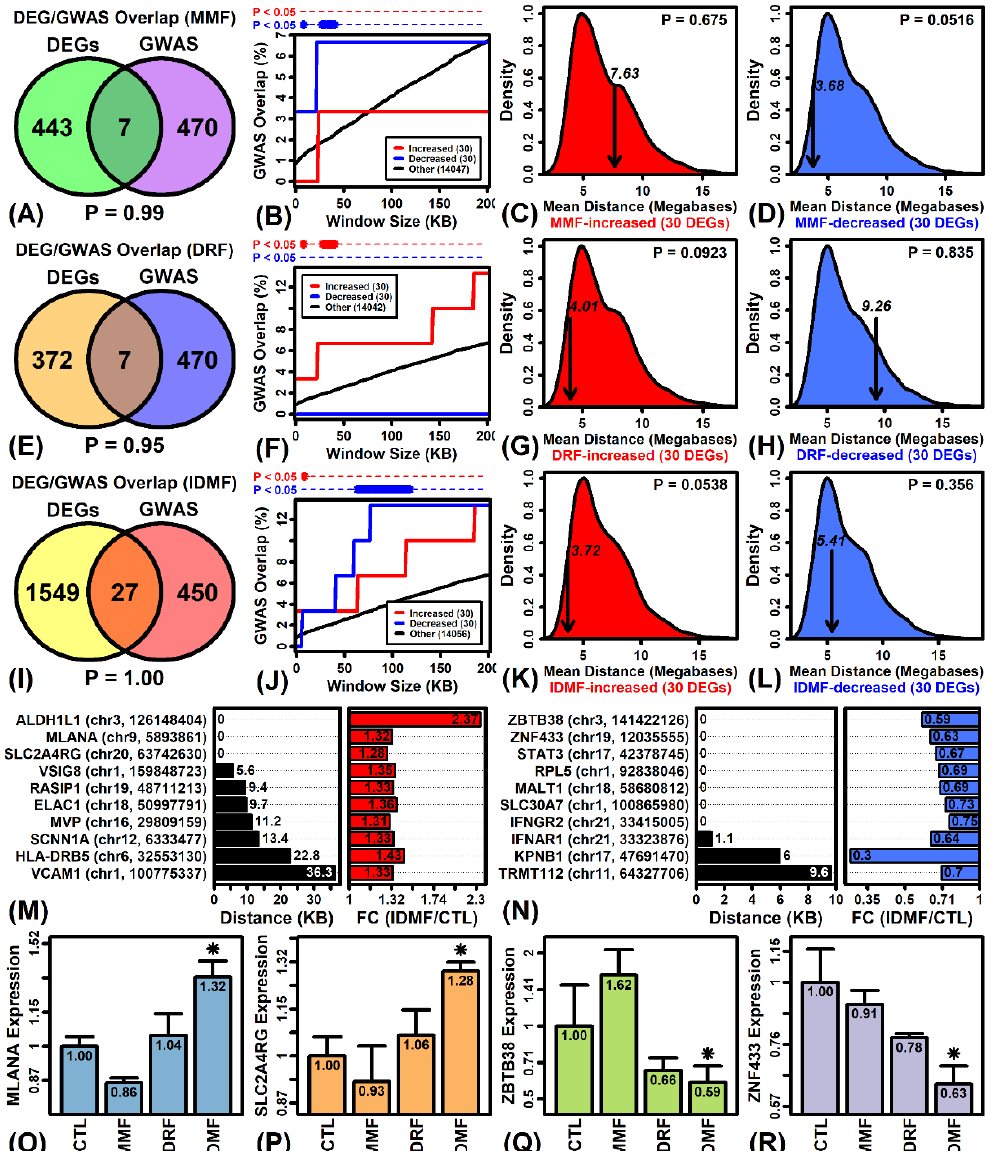
Figure 7. MS-associated genes from GWAS studies and their overlap with DEGs. ( A , E , I ) Overlap between DEGs and MS-associated genes from the NHGRI-EBI GWAS Catalog (reported, mapped, upstream, or downstream). DEGs were identified based on the same threshold in each analysis ( p < 0.05, FC > 1.25 or FC < 0.80; bottom p -value: Fisher’s exact test for overlap). ( B , F , J ) Genes at varying distances from MS GWAS loci (horizontal axis) and their overlap with the top 30 genes most strongly increased/decreased by MMF, DRF, or IDMF (black line: overlap with respect to all other genes). Cases of significant overlap are indicated in the top margin ( p < 0.05, Fisher’s exact test). ( C , D , G , H , K , L ) Average distance between the top 30 genes most strongly altered by MMF, DRF, or IDMF and the nearest MS GWAS locus (arrow). The distribution is obtained from 1000 simulation trials in which 30 genes were selected at random, with the average distance to the nearest MS GWAS locus calculated in each trial. ( M , N ) IDMF-increased/decreased genes nearest to an MS GWAS locus. For each gene, the distance to the nearest MS GWAS locus is shown (left) along with estimated fold- change (IDMF/CTL) (right). ( O – R ) Selected IDMF-responsive genes near MS GWAS loci. Average expression ( ± 1 standard error) is shown for each treatment (* p < 0.05, comparison to